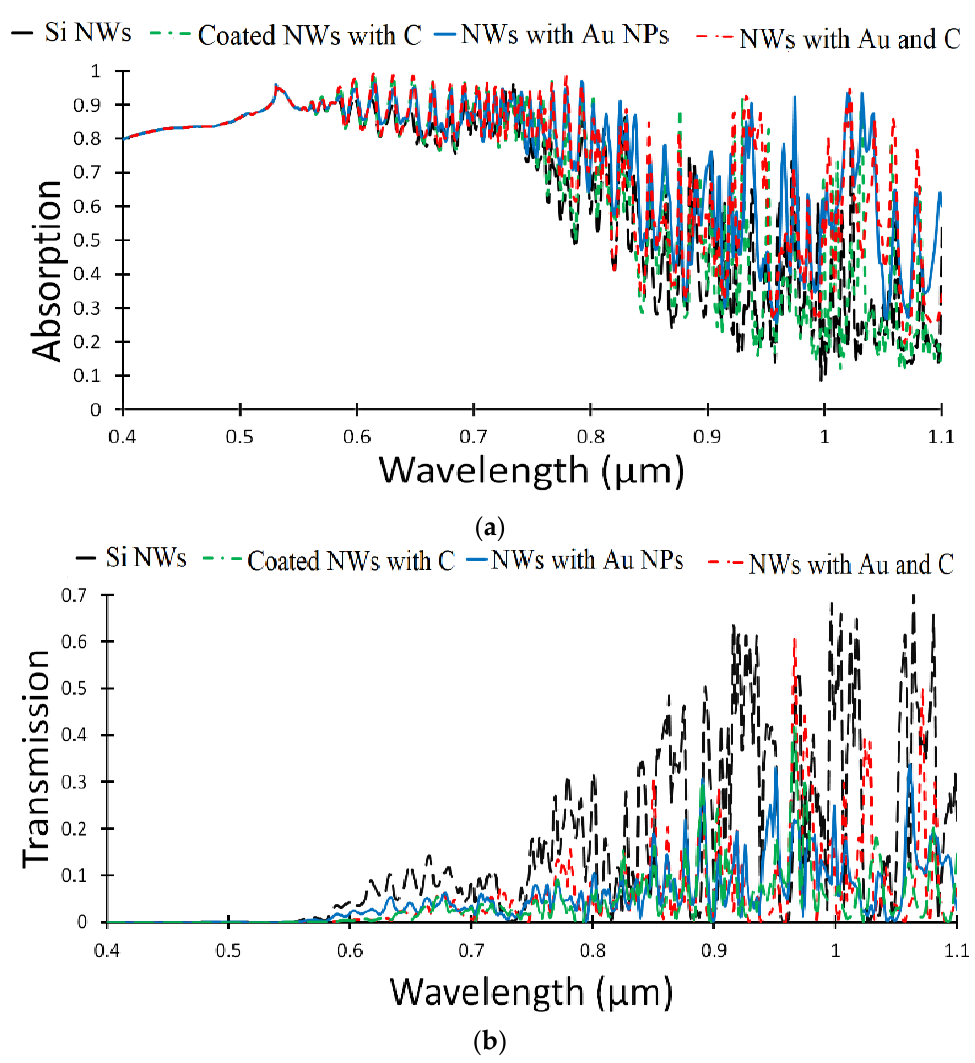
Figure 2. ( a ) Absorption and ( b ) transmission of the four proposed structures: traditional SiNWs, SiNWs coated with a graphene layer, SiNWs with Au NPs distributed on the substrate, and SiNWs with graphene layer and Au NPs.